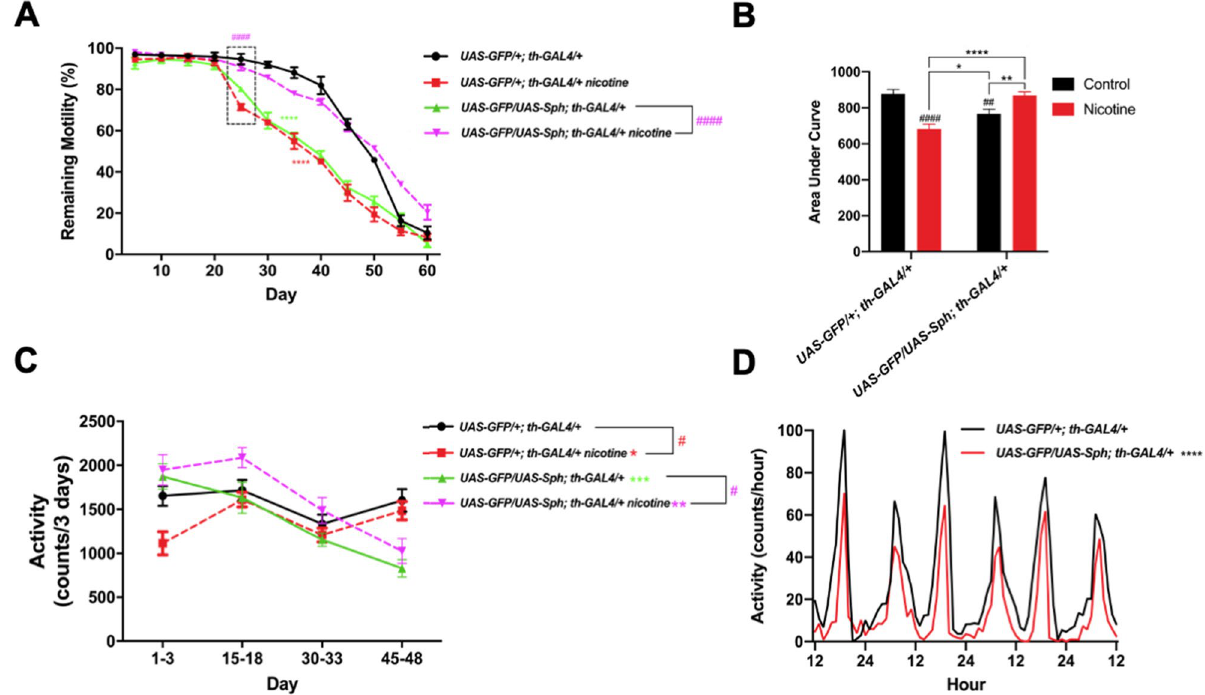
Figure 3. Nicotine rescues spontaneous and startle-induced motility in animals that express Sph-1 but deteriorates locomotion in control flies. ( A ) Startle-induced response of flies of the control genotype ( UAS- GFP/ + ; th-GAL4/ +) (black solid lines) exhibit a startle-induced response that is reduced when animals are treated with nicotine (red dotted lines). Startle-induced motility is significantly better when experimental genotype Sph-1 animals ( UAS-GFP/UAS-Sph; th-GAL4/ +) (green solid lines) are treated with nicotine (magenta dotted lines). ( B ) Cumulative locomotion in startle-induced experiments was assessed as area under the curve from data presented in ( A ). Results show that motor response is reduced in the Sph-1 expressing flies compared with the control genotype and that motility is rescued when experimental animals are treated with nicotine (## indicates p < 0.01 compared with control group). In addition, a significant decrease in motor response is observed in control flies treated with nicotine compared with flies that did not receive nicotine (#### indicates p < 0.0001 compared with control situation). ( C ) Control animals (black solid lines) exhibit spontaneous activity that significantly decreases when flies are treated with nicotine (red dotted lines) while spontaneous activity is rescued in the Sph-1 expressing ones (magenta dotted lines). In ( A – C ), two-way ANOVA followed by Tukey’s post-hoc was used to evaluate statistical differences between experimental groups. In all conditions n = 100, * indicates p < 0.05; ** indicates p < 0.01; ****indicates p < 0.0001. Data from untreated flies are represented in dotted lines, while data from nicotine-treated animals are shown in solid lines. ( D ) Actograms of control and Sph-1 expressing flies. Data from control genotype are presented in black, data from Sph-1 expressing flies is shown in red. Two-way ANOVA followed by Tuckey’s post-hoc, ****indicates p < 0.0001 between groups, n = 14 animals per group. All treated animals were chronically exposed to 24 µM